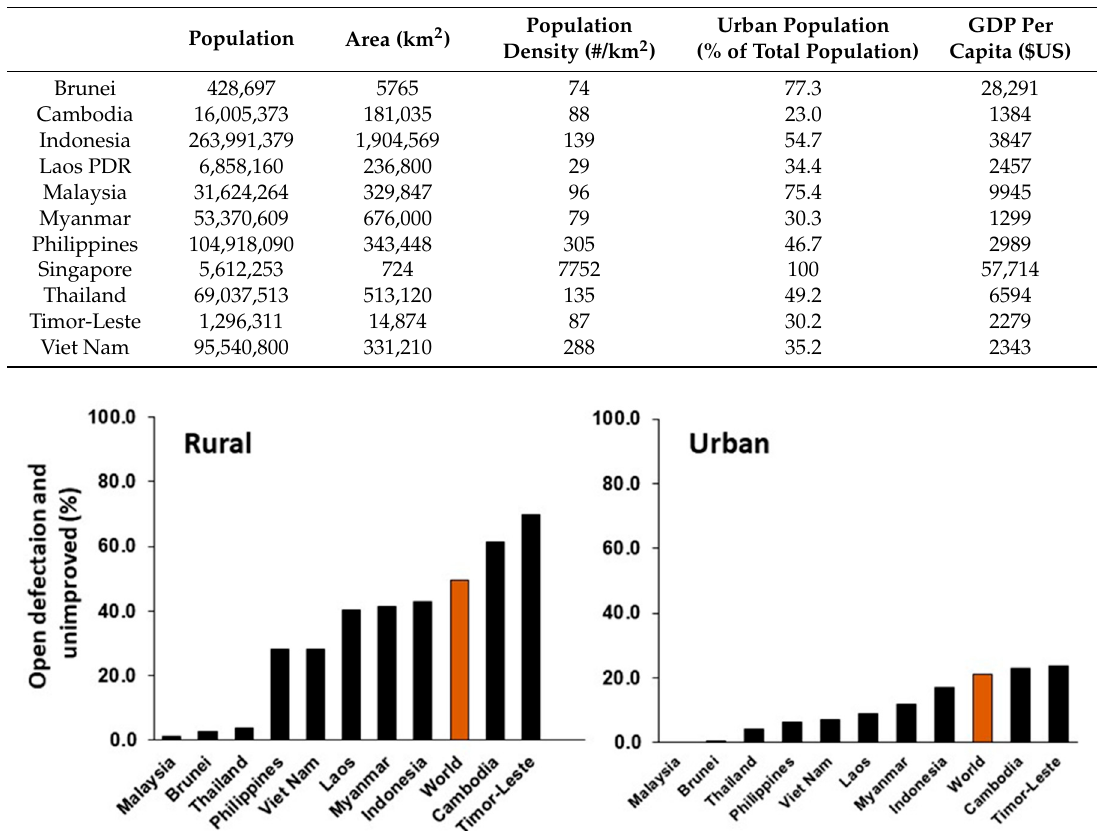
Table 1. Total population [13], percent level of urban population [16] and GDP per capita [15] for the eleven countries in the case study based on 2017 data.